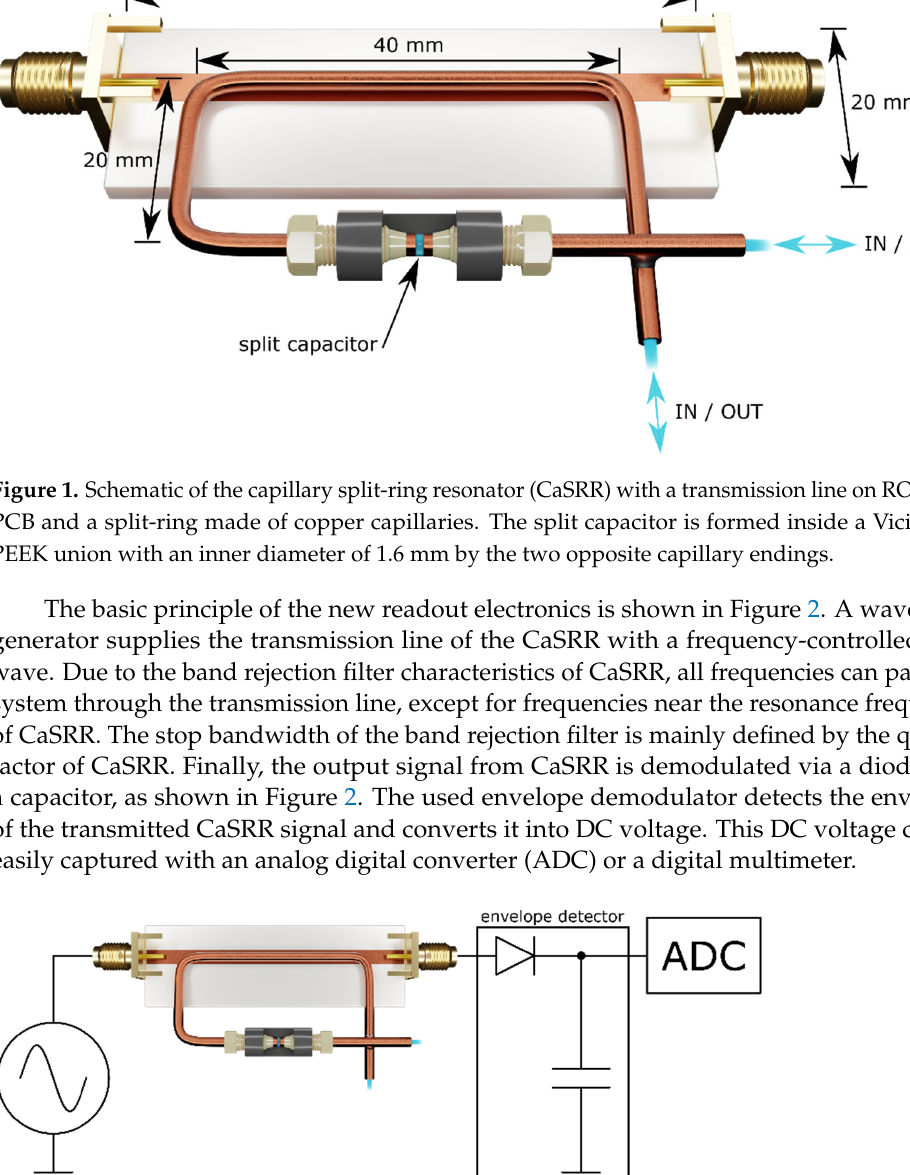
Figure 2. Basic concept of the new readout electronics consisting of a frequency ‐ controlled sine ‐ wave generator, the CaSRR, a demodulator (envelope detector), and an ADC.